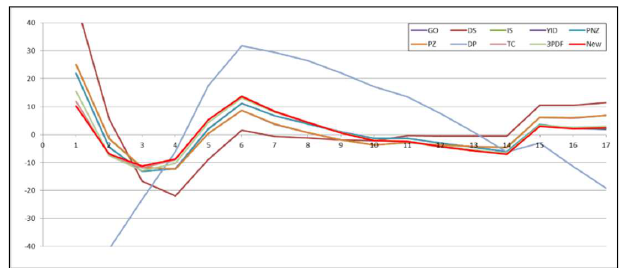
Figure 9. Relative error of the ten models for DS2.